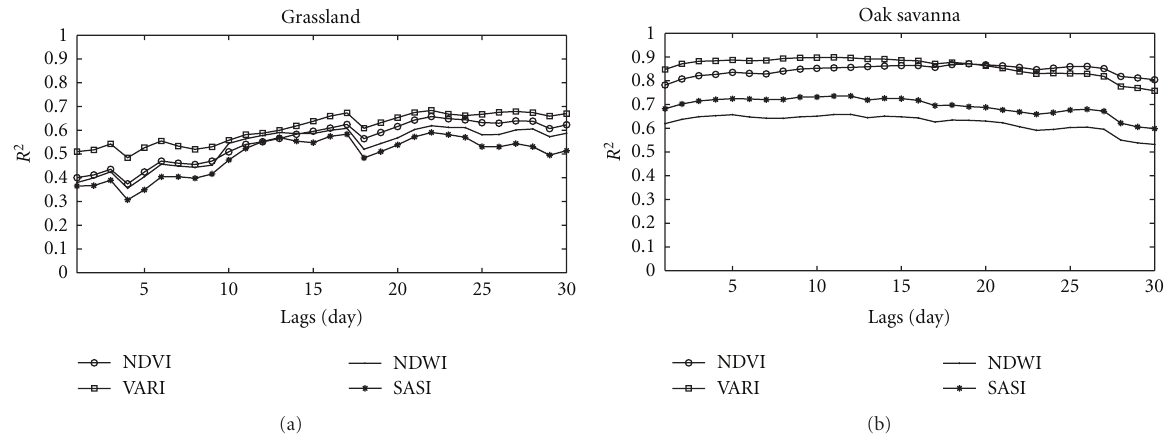
Figure 6: The correlation coe ffi cients between VIs and soil moisture lagged up to 30 days at 10cm in open grassland (a) and at 20 cm in oak savanna (b) during the dry-down and senescence